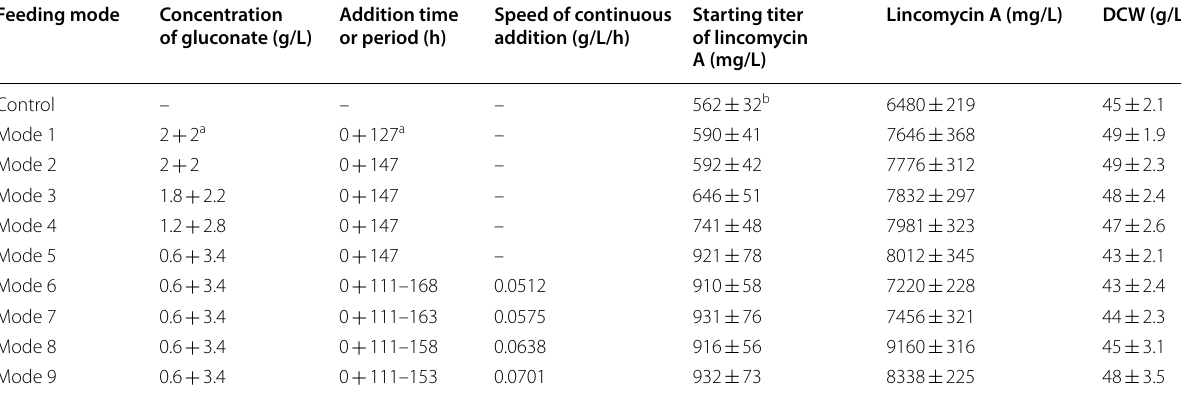
Table 1 The production of lincomycin A with various feeding modes of gluconate Feeding mode